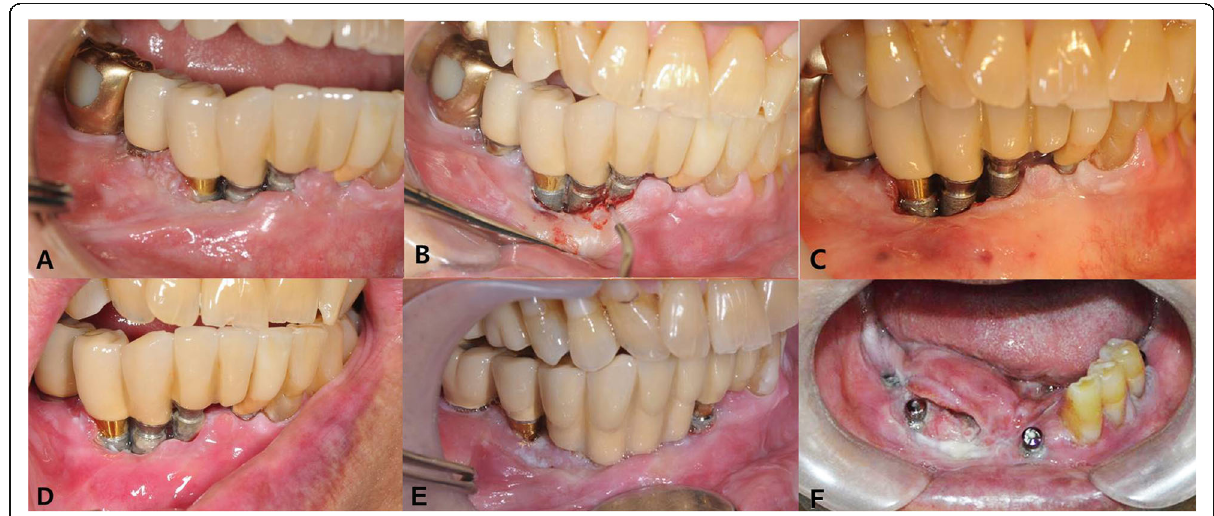
Fig. 1 Clinical photos of the patient. a Initial visit; b peri-implantitis treatment with laser; c after 3-times laser treatment; d 5 months after initial visit; e 3 years after initial visit, the lesion was confirmed OSCC by incisional biopsy; f preoperative view show bulging tumor mass to lingual